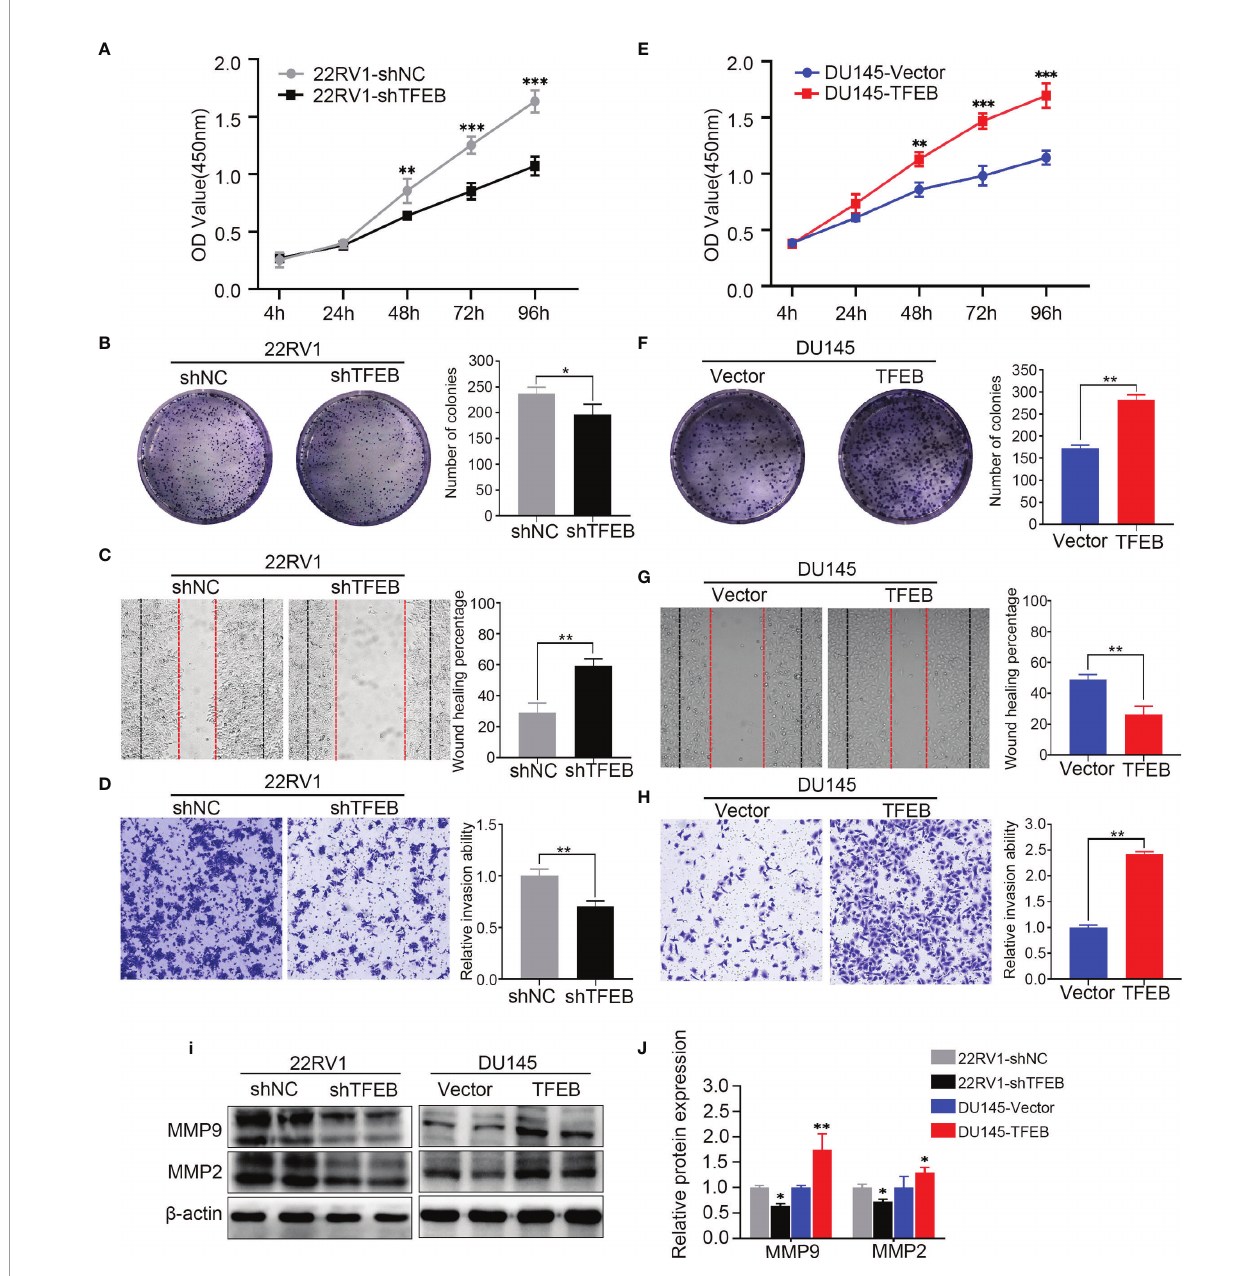
FIGURE 2 | Overexpressing or knockdown expression of TFEB signi fi cantly effect PCa cell proliferation, tumorigenicity, invasion, and migration. (A – D) Overexpression of TFEB promotes cell proliferation, invasion, and migration in vitro experiment. (E – H) Knock down expression of TFEB inhibit cell proliferation, invasion and migration in vitro experiment. (A, E) CCK-8 assay. (B, F) Colony formation assay. (C, G) Wound healing assay; Black dashed line indicates 0-h, red dashed line indicates 48h. (D, H) Transwell assay; cancer cells were stained after 24h. Quantitative analysis of the colony formation assay, wound healing assay and transwell assay from panel left respectively, those assays were repeated three times. (I, J) Quantitative protein expression of MMP2 and MMP9 by western-blot in TFEB overexpressed or knock-down PCa cell lines. Statistical analysis was from three independent experiments and is presented as mean ± SD. * p < 0.05, ** p < 0.01, ***p < 0.001 compared with control